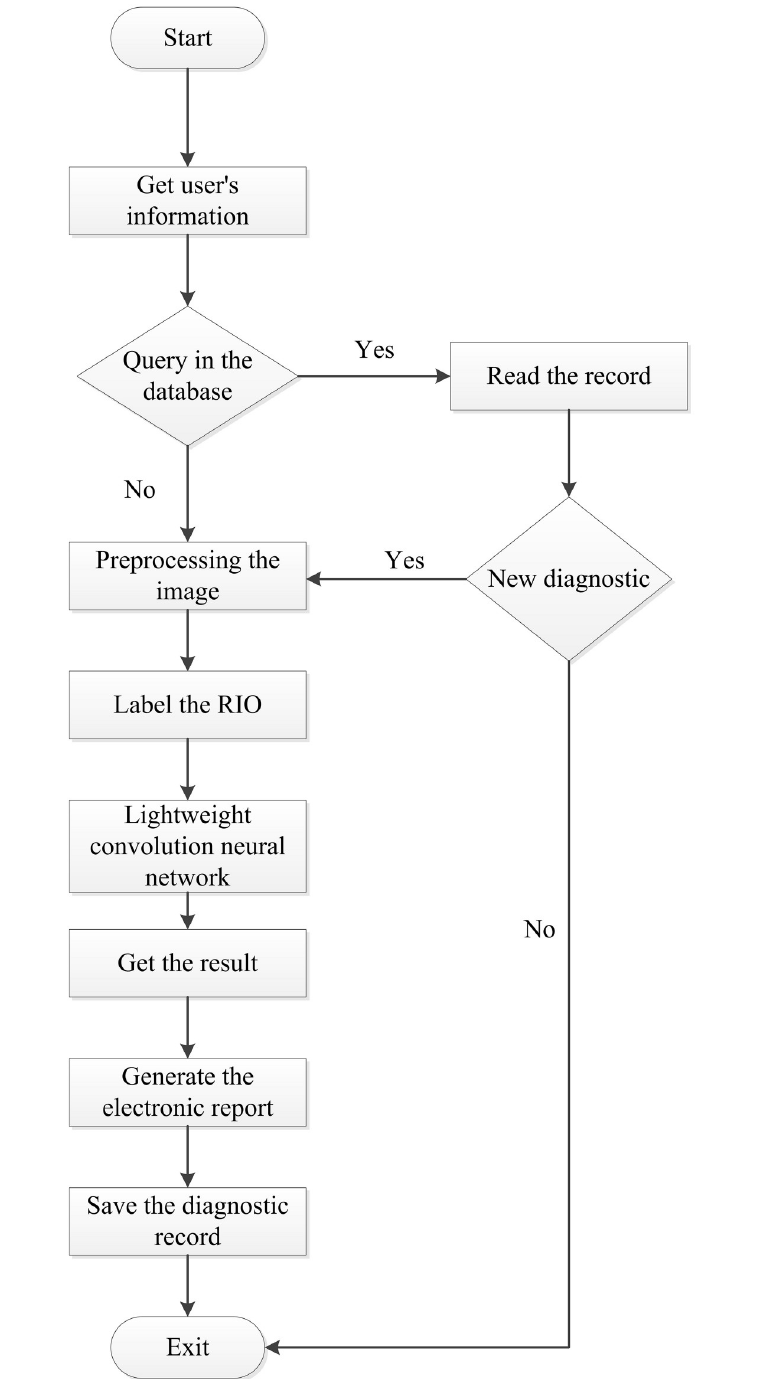
Fig 1. The flowchart of recognizing cholelithiasis.